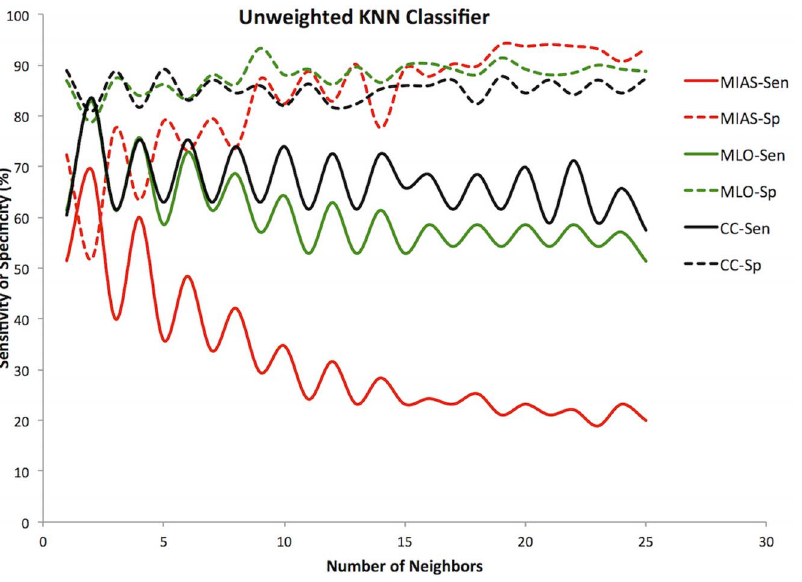
Figure 1. Unweighted KNN classifier. Sensitivity (Sen, solid lines) and specificity (Sp, dashed lines) versus Number of Neighbors for all three datasets. MIAS (red), DDSM MLO (green), DDSM CC